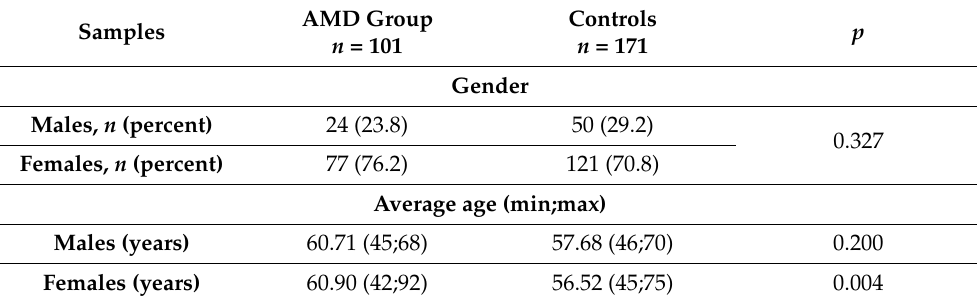
Table 4. Comparison of mean optical density and genotypes of SNP rs11057841 in SCARB1 gene. Genotype